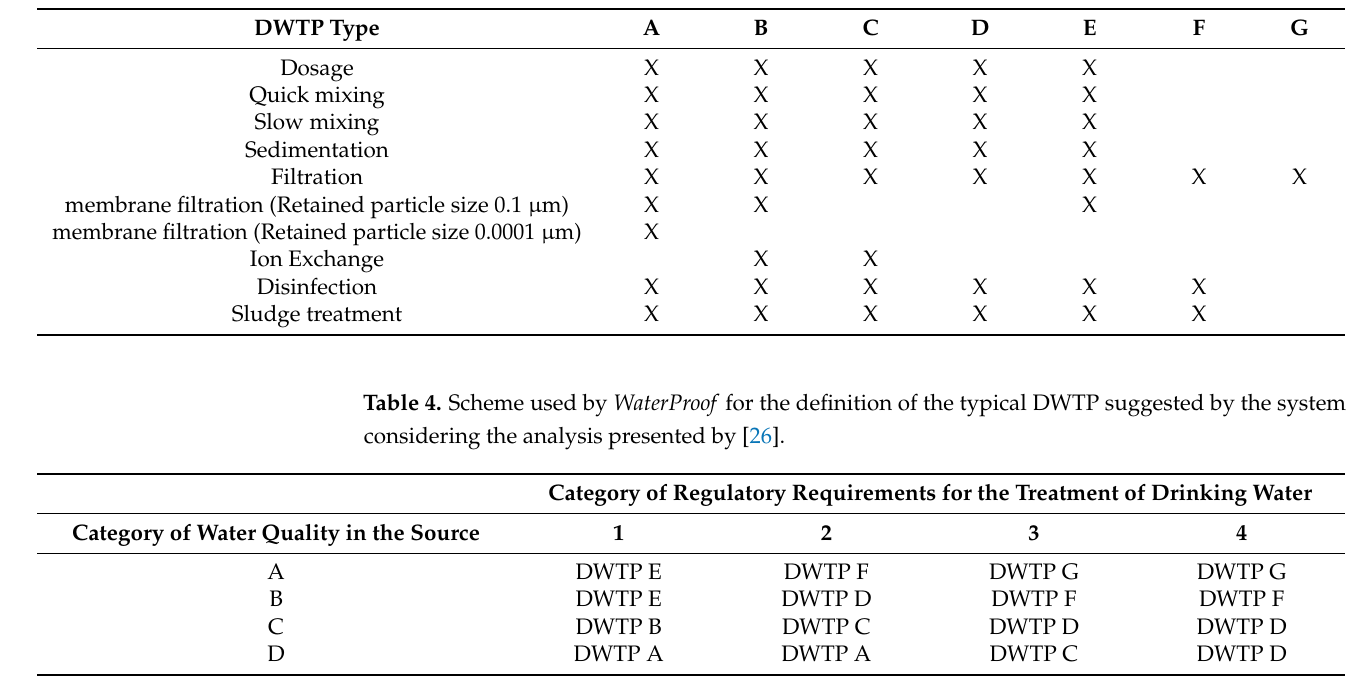
Table 3. Active treatment train processes for each type of DWTP.